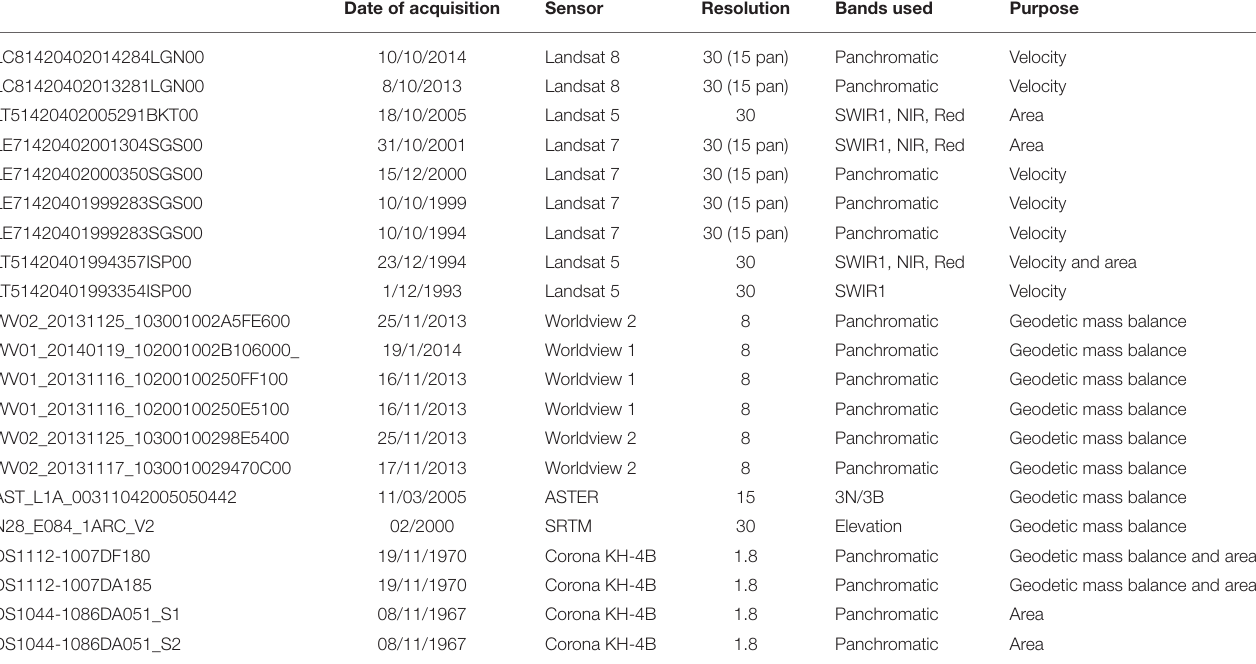
TABLE 1 | The data used in this study and the purpose of each data source.